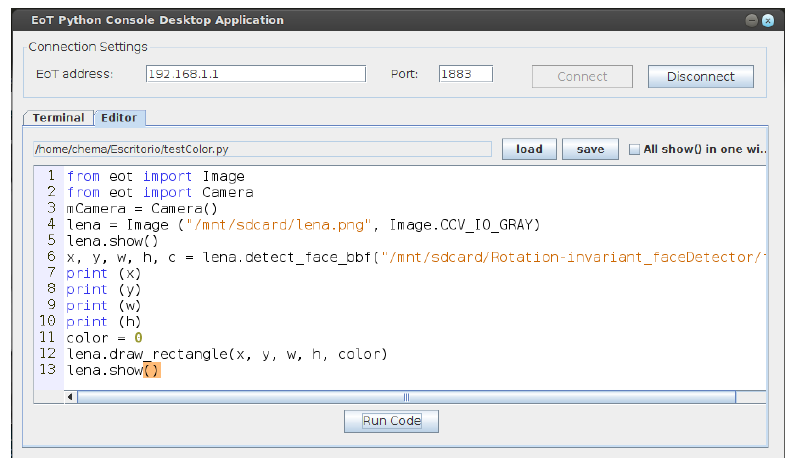
Figure 18. EoT MicroPython remote terminal and editor showing a simple vision